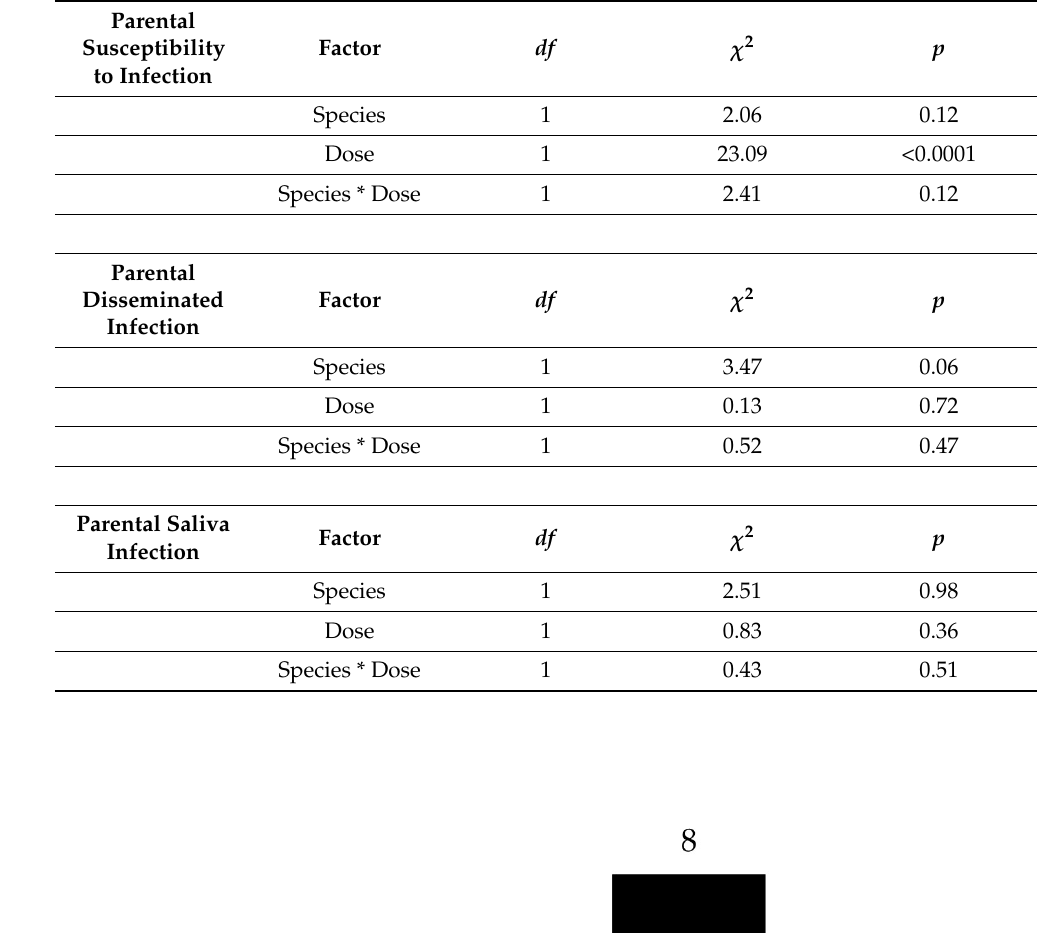
Table 1. Contingency table analysis of parental infection of female Ae. aegypti with Zika virus following an incubation period after ingestion of either 6 or 7 log 10 PFU/mL of Zika virus infected blood. The species by dose interaction is represented by Species * Dose.